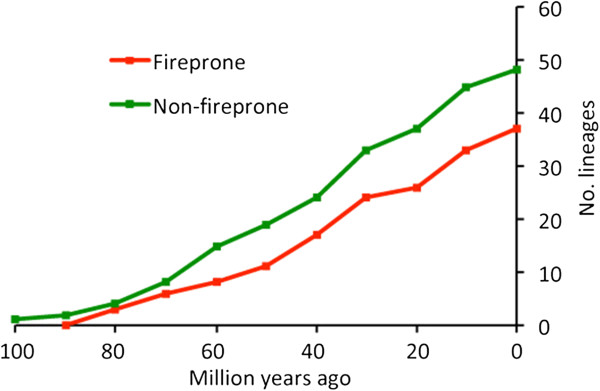
Proliferation of lineages assigned to fireprone and non-fireprone habitats at 10 My intervals from the estimated time of origin of the Proteaceae (collated from Figure1a).